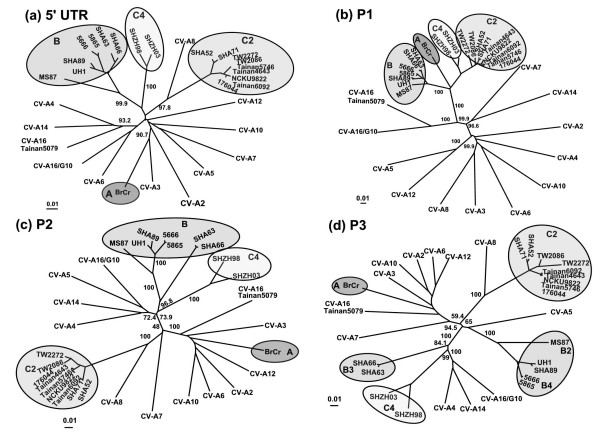
Unrooted phylogenetic trees showing the relationships amongst HEV-A isolates using the different genomic regions. The neighbour-joining trees were constructed from alignment of the 5' UTR (a), P1 (b), P2 (c) and P3 genomic region (d), respectively. The percentage of bootstrap replicates supporting the trees are indicated at the nodes. The branch lengths are proportional to the genetic distances corrected using Kimura-two-parameter substitution model.